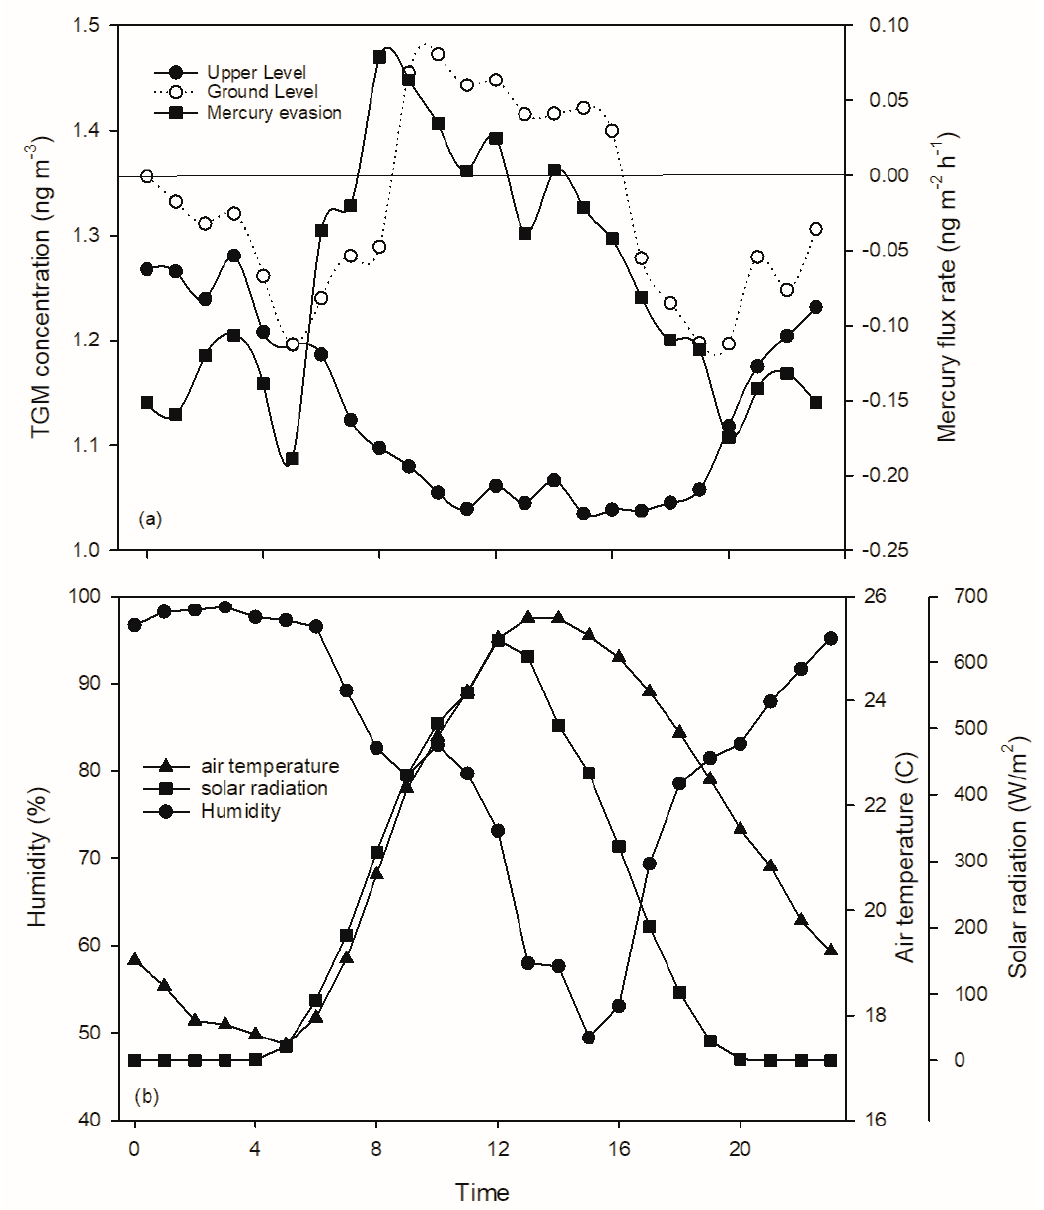
Figure 7. Diurnal pattern of TGM concentrations at the ground level and at height with mercury evasion flux from soil in June 2015 at the Syracuse CoE ( a ). Values are mean over the observations of the month. Shown also are air temperature, solar radiation, and relative humidity ( b ).